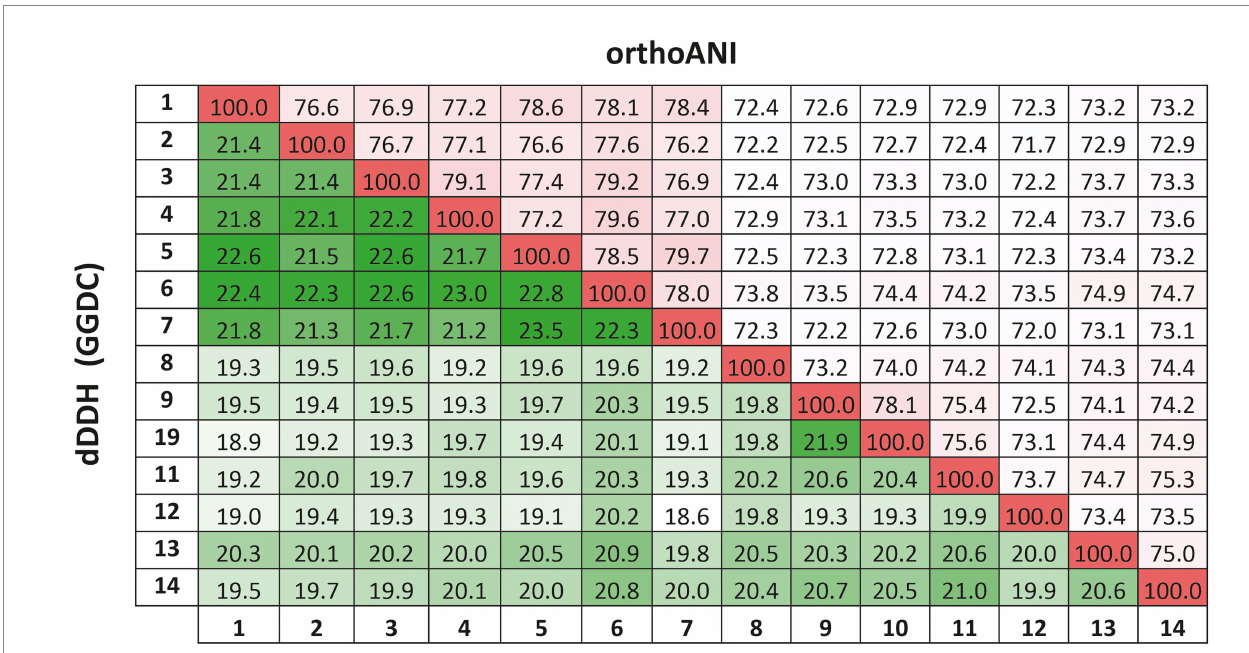
FIGURE 5 Average Nucleotide Identities (orthoANI) and digital DNA–DNA hybridization (dDDH) calculated by the Genome-to-Genome Distance Calculator (GGDC) percentages of strain F2-12 T , the species of the genus Natronomonas and other related genera. Strains: 1, Natronomonas aquatica F2-12 T (GCA_024449025.1); 2, Natronomonas pharaonis DSM 2160 T (GCA_000026045.1); 3, Natronomonas gomsonensis JCM 17867 T (GCA_013391635.1); 4, Natronomonas halophila C90 T (GCA_013391085.1); 5, Natronomonas moolapensis 8.8.11 T (GCA_000591055.1); 6, Natronomonas salina YPL13 T (GCA_013391105.1); 7; Natronomonas salsuginis F20-122 T (GCA_005239135.1); 8, Halapricum salinum CBA1105 T (GCA_004799665.1); 9, Haloarcula vallismortis ATCC 29715 T (GCA_000337775.1); 10, Halomicroarcula pellucida JCM 17820 T (GCA_014647235.1); 11, Halomicrobium mukohataei DSM 12286 T (GCA_000023965.1); 12, Halorhabdus utahensis DSM 12940 T (GCA_000023945.1); 13, Halorientalis regularis IBRC-M 10760 T (GCA_9001023 05.1); 14, Halosimplex carlsbadense 2-9-1 T